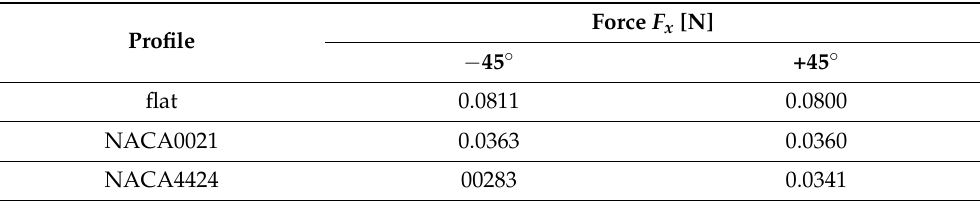
Table 2. Calculated drag forces for narrow channel.